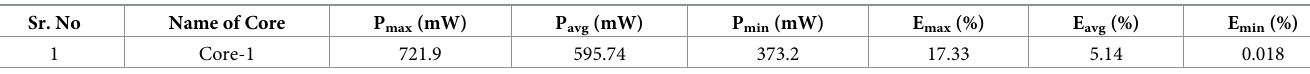
Table 2. Power estimates and accuracy for test-system